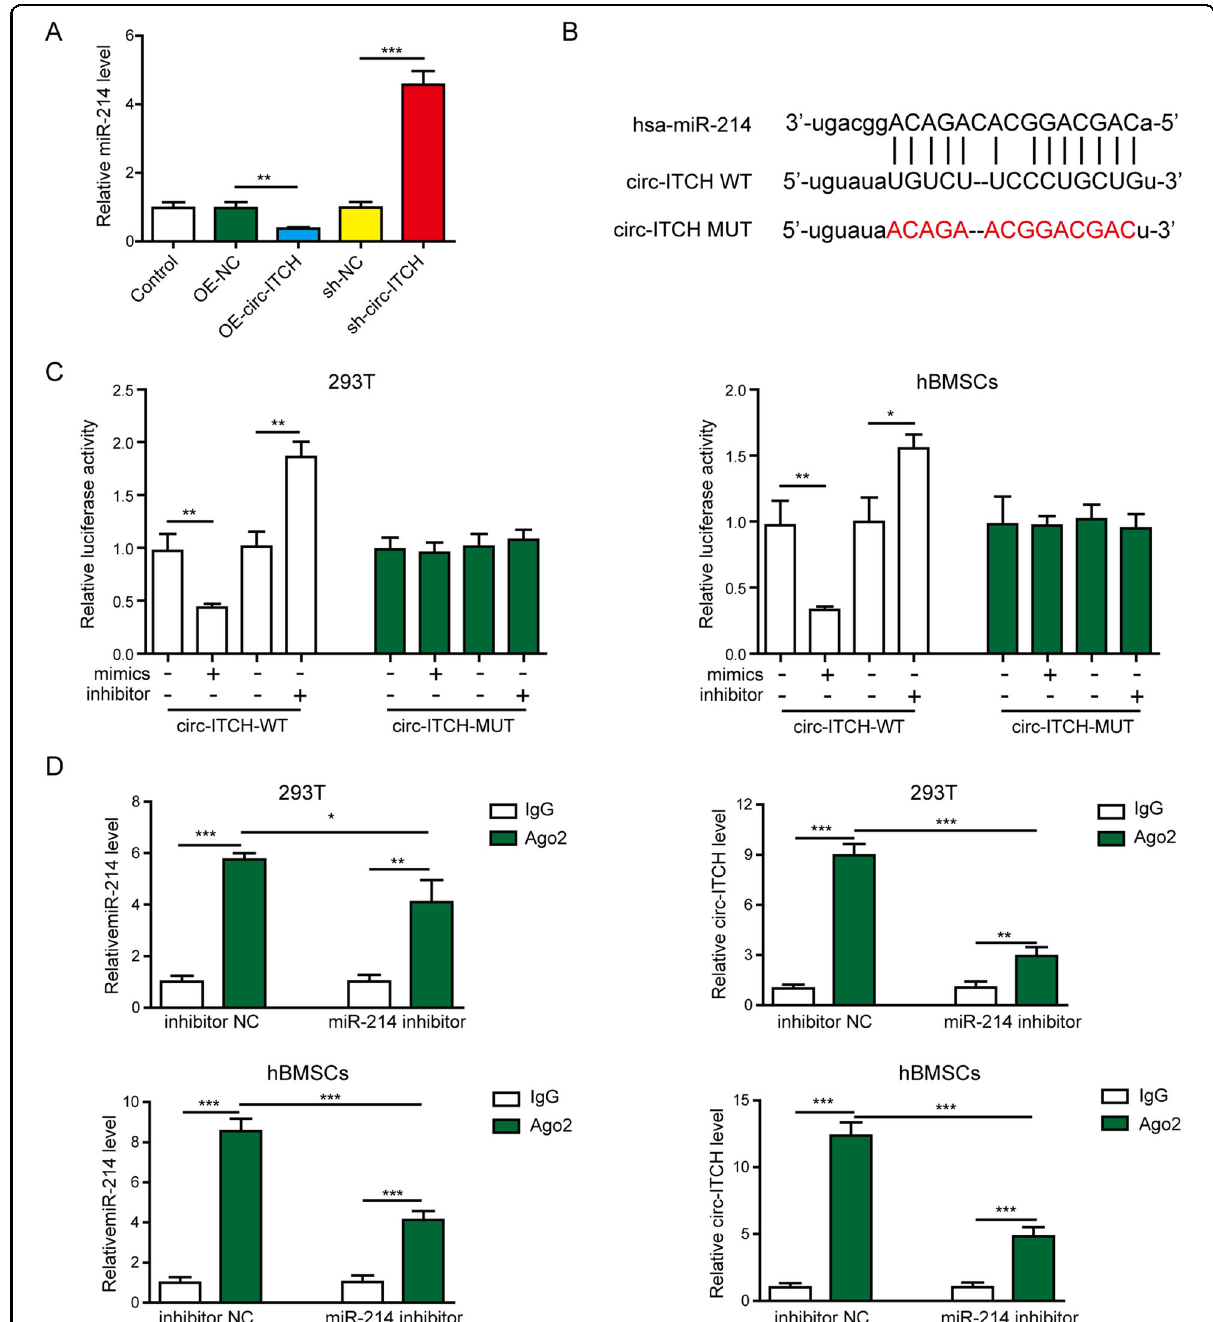
Fig. 3 Circ-ITCH directly targeted and suppressed miR-214 expression. A hBMSCs were transfected with circ-ITCH overexpressing lentivirus, sh- circ-ITCH lentivirus or their negative controls for 48 h, and then expression level of miR-214 was measured by RT-qPCR. B StarBase analysis showed the potential binding sites for circ-ITCH and miR-214. C The luciferase activity was measured by dual-luciferase reporter assay in 293T cells and hBMSCs transfected with miR-214 mimics, miR-214 inhibitor or their negative controls for 48 h. D RIP assay was used to verify the association of circ- ITCH with miR-214 in 293T cells and hBMSCs. * P < 0.05, ** P < 0.01, and *** P <